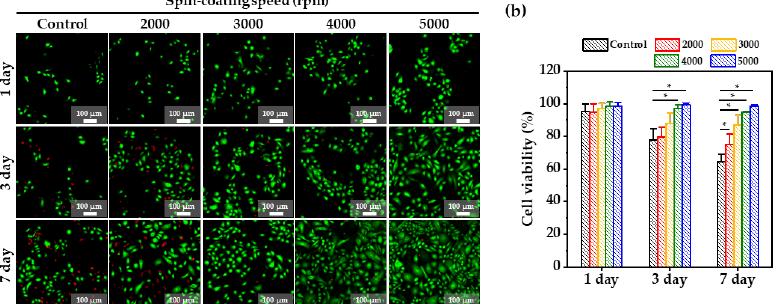
Figure 4. ( a ) Fluorescence images of a live and dead assay of keratinocyte cells cultured for 7 days on the PDMS membranes according to spin-coating speed; green – live cells; red – dead, and ( b ) Cell viability obtained from LIVE and DEAD assay at days 1, 3, and 7. *: p -value < 0.05.